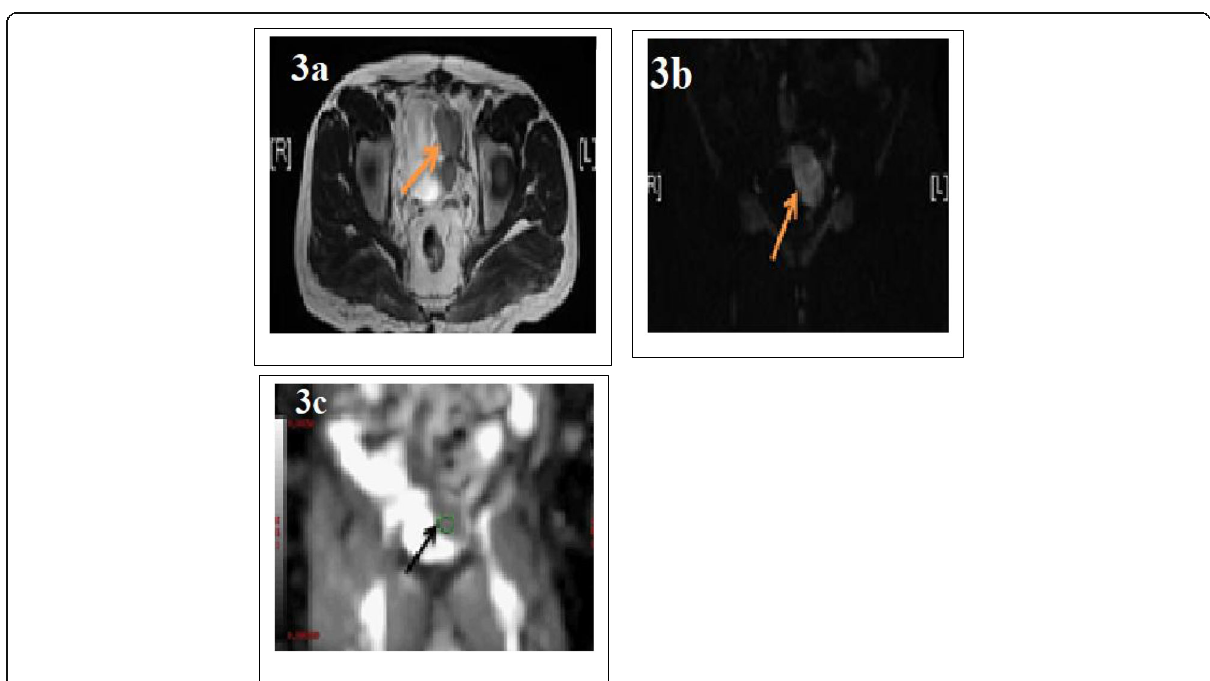
Fig. 3 Squamous cell carcinoma with extensively infiltrating the lamina propria and preserved muscle layer (stage T2, grade2). a T2WI showing soft tissue mass lesion at the left lateral wall of the urinary bladder, stage T2. b DWIs, the soft tissue mass lesion showing evidence of restricted